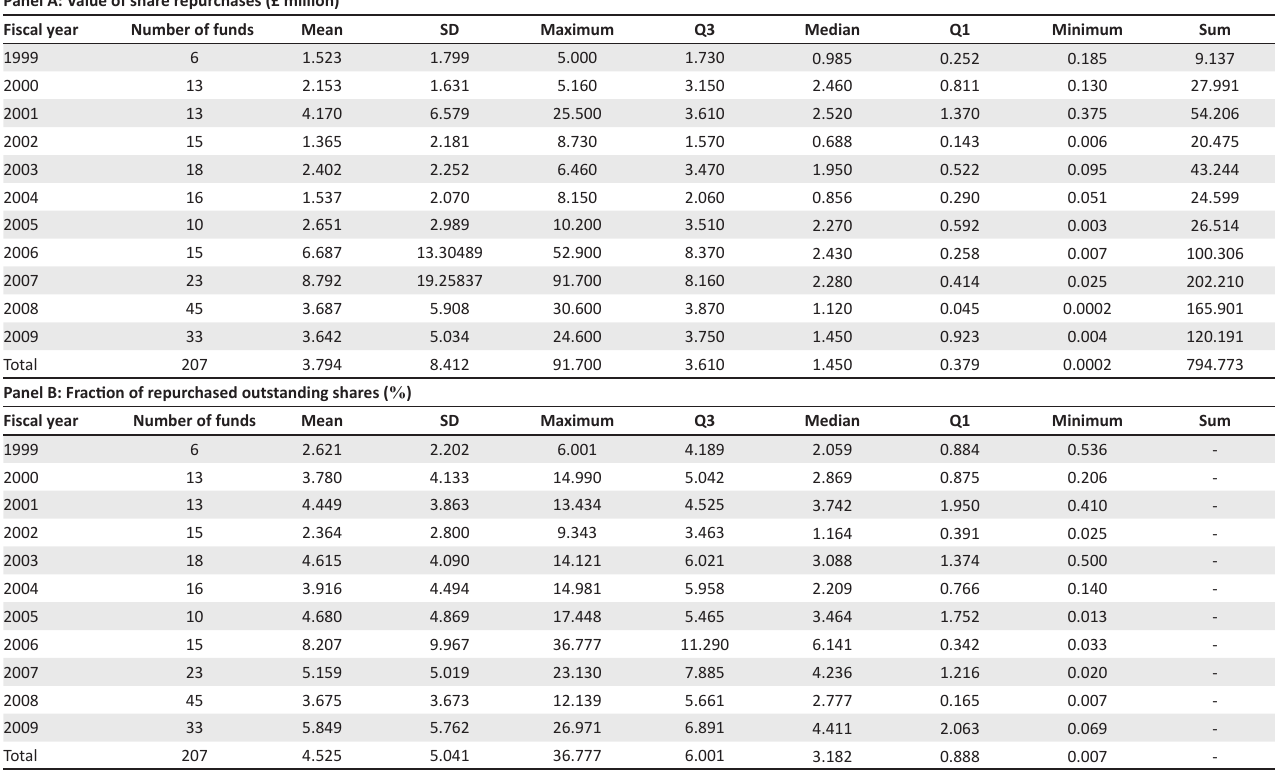
Table 4: Summary of statistics for share repurchases of UK closed-end funds. Panel A: Value of share repurchases (£